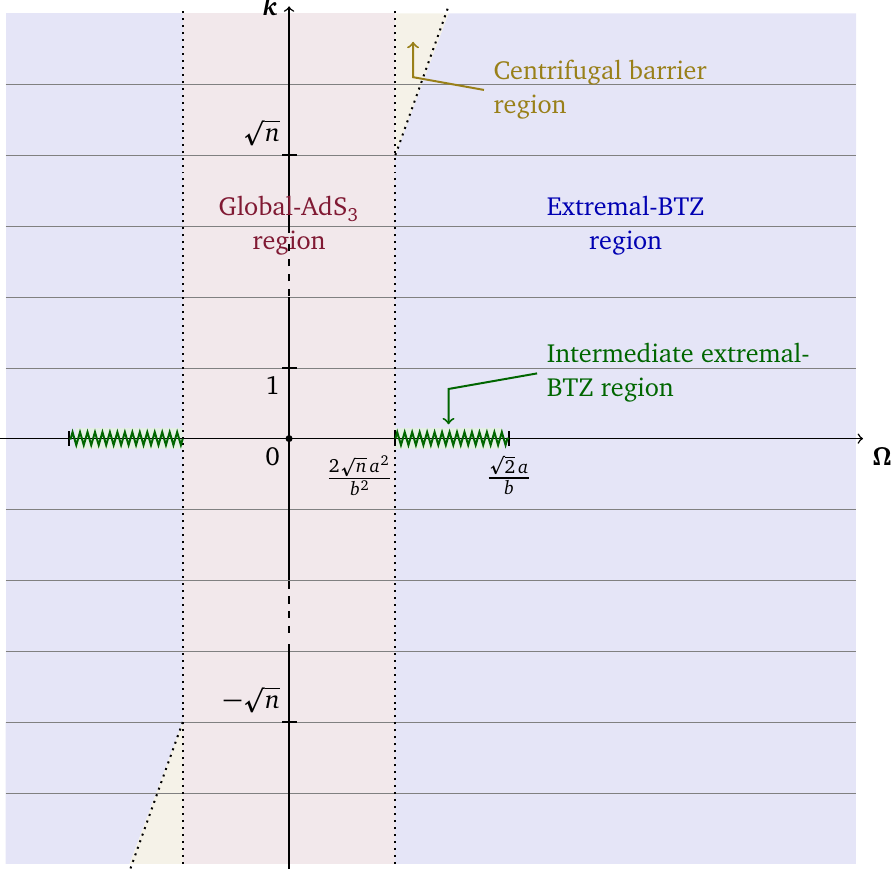
Figure 5: The four regimes for the (1,0,n)-superstratum response function as a func- tion of Ω and k = Ω + P . For very small Ω , the wave goes far inside the throat and